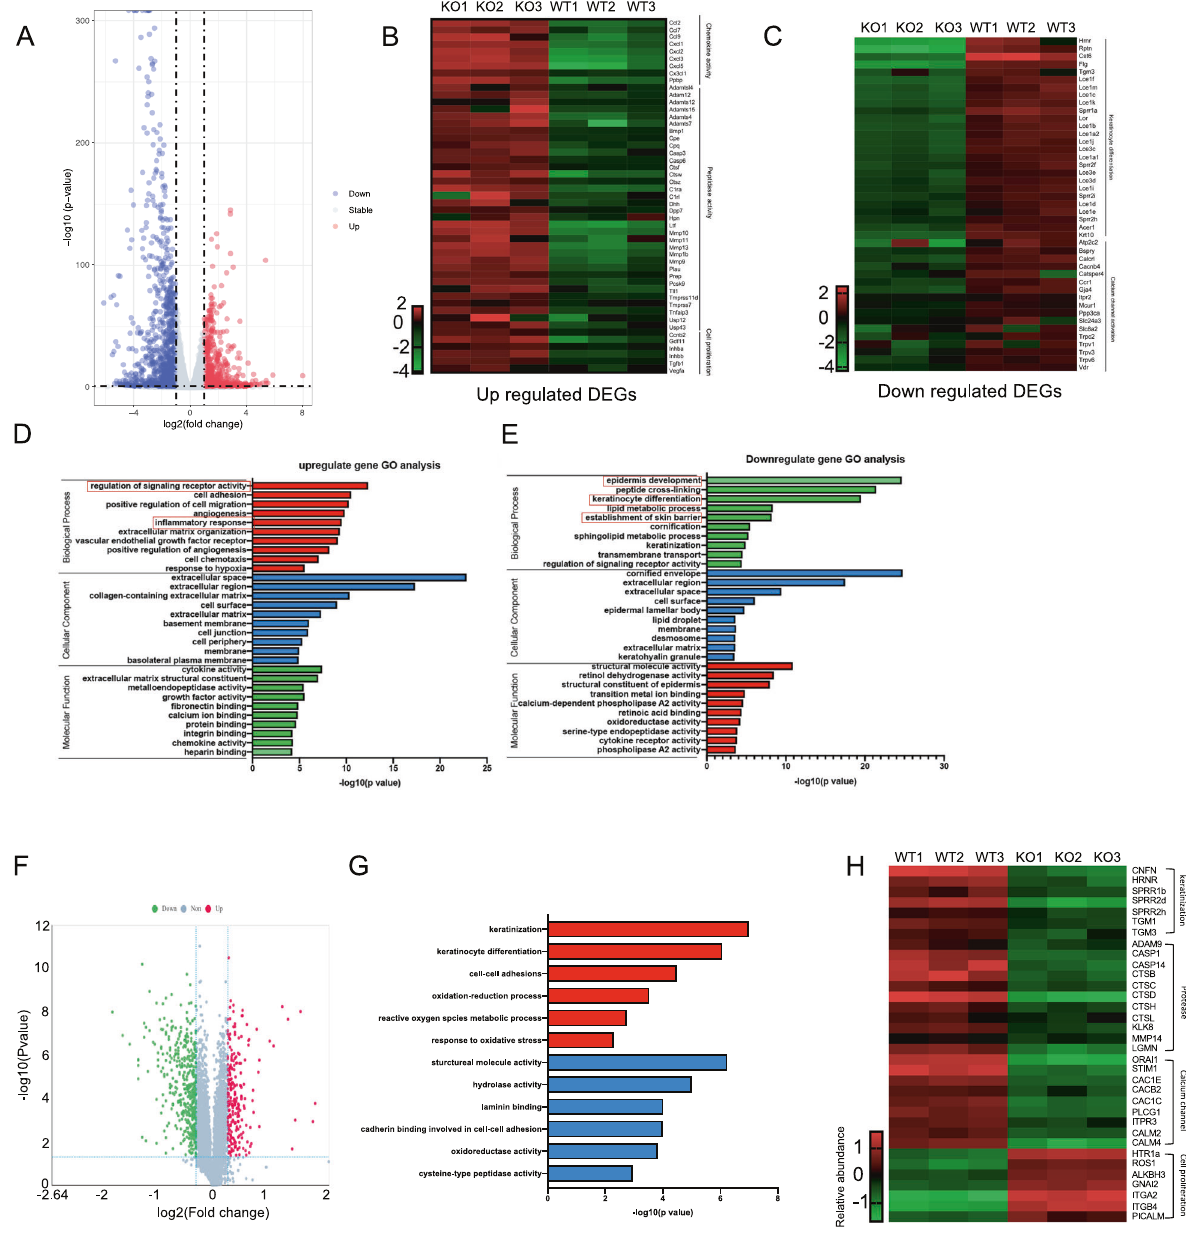
Fig. 5 SerpinB7 de fi ciency affects the expression of genes related to calcium channels in differentiated keratinocytes. A Volcano plots plotting the log2 fold-change of transcriptomics in SerpinB7 de fi ciency vs. control differentiated keratinocyte. Blue color indicates transcripts with fold-change (FC) < 0.67 while red color those with FC > 1.5. B , C Heatmaps showing the upregulated (left) and downregulated (right) genes in SerpinB7 de fi ciency differentiated keratinocytes. D , E The top 10 most relevant biological processes, cellular components, and Molecular function gene ontology (GO) are sorted according to the adjusted P value. F Volcano plots plotting the log2 fold-change of proteomics in SerpinB7 de fi ciency vs. control differentiated keratinocyte. Blue color indicates transcripts with FC < 0.83 while red color those with FC > 1.2. G The top 5 most relevant biological processes upregulated and downregulated GO are sorted according to the adjusted P value. H Heatmaps showing the keratinization, protease, calcium channel, and cell proliferation